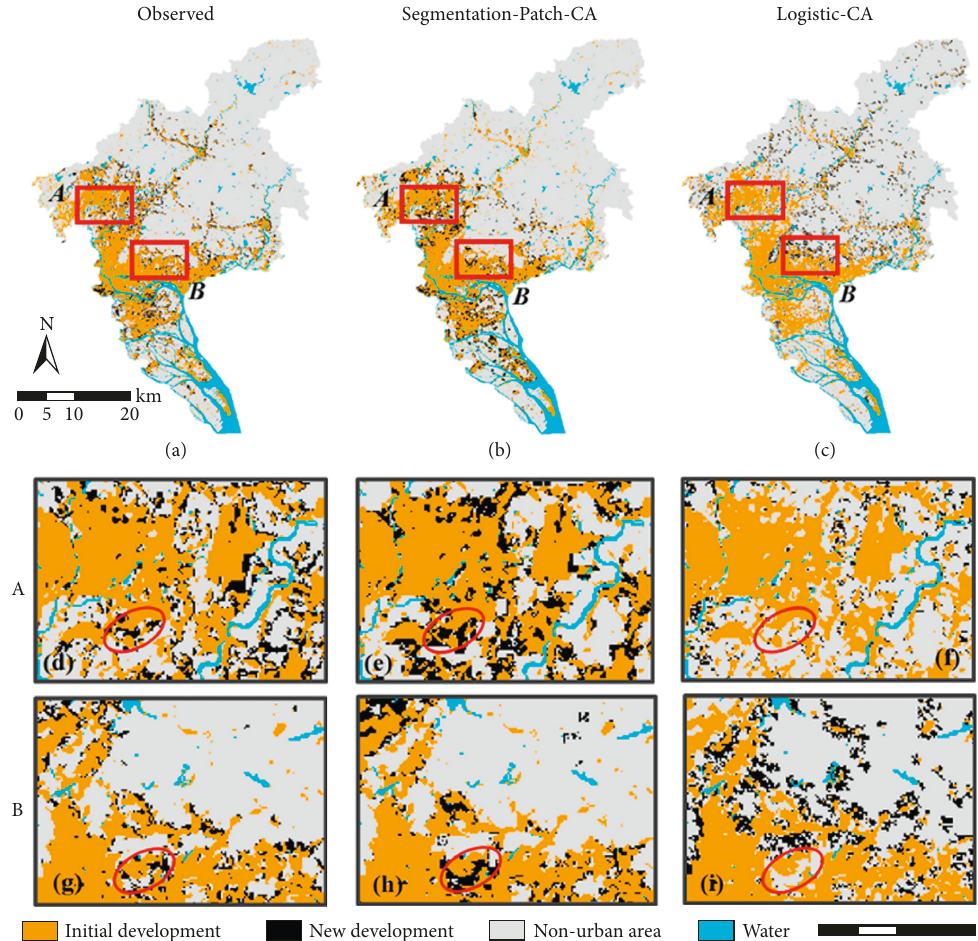
Figure 5: Chen’s CA model applied in Shenzhen (China) 100 simulations overlapping ( r � 2) for (a) industrial land; (b) residential land; and (c) commercial land